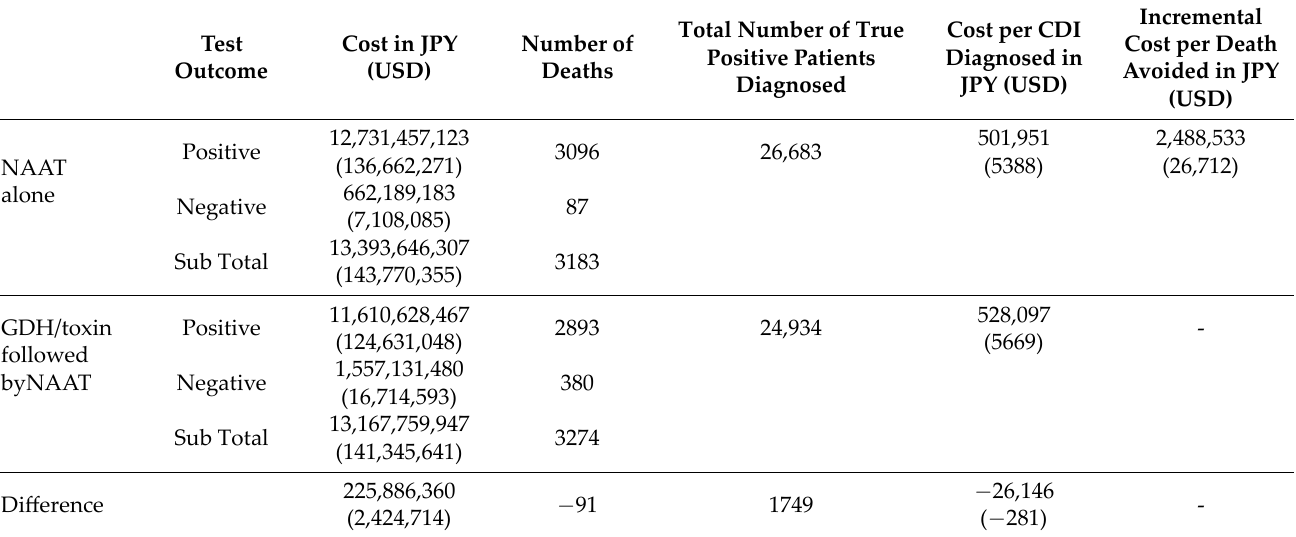
Table 3. Cost and clinical outcomes of 100,000 patients suspected with CDI from the two different diagnostic